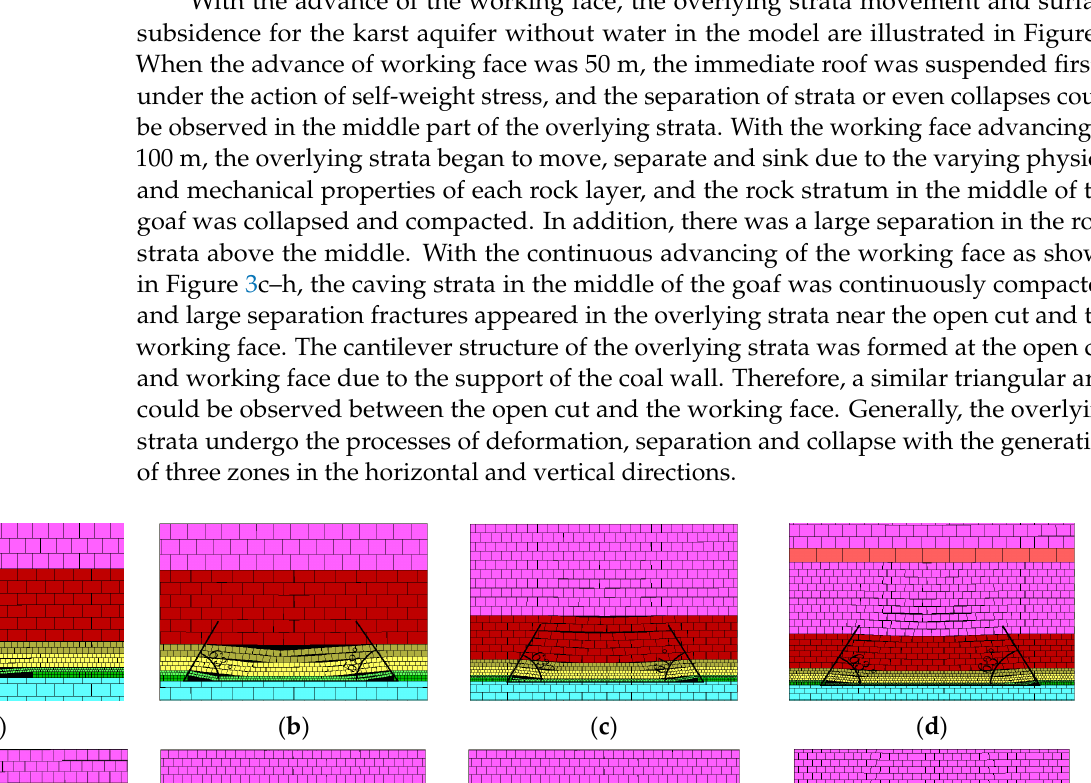
Table 2. Summary of overlying strata caving angles with different advance distances.